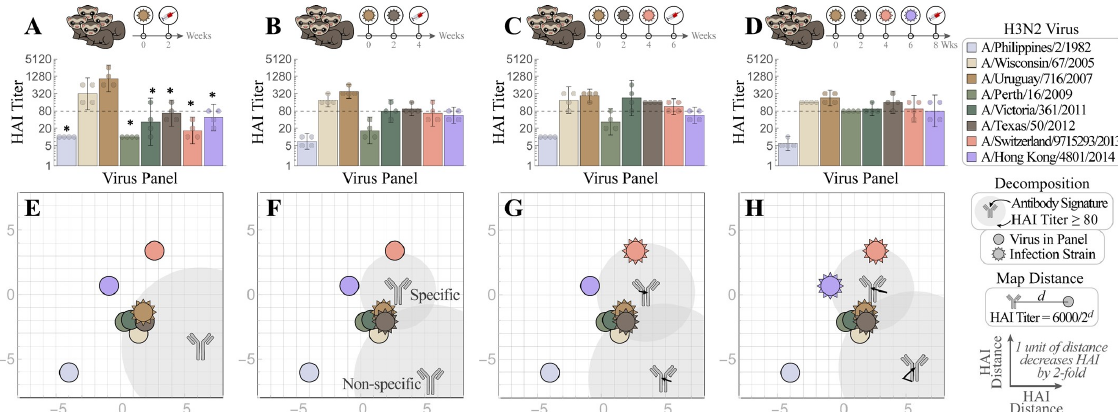
(i.e., that strongly inhibited all infection strains) and another “non-specific” antibody sig-